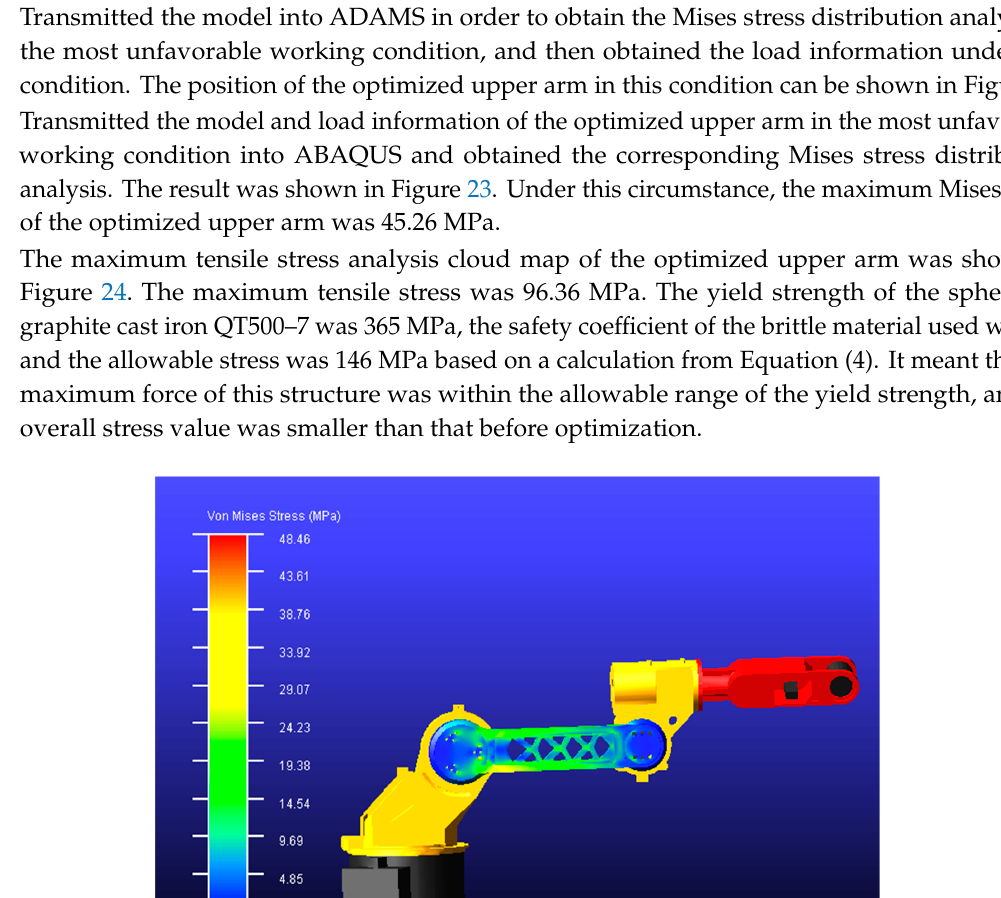
Figure 22. The position of the optimized upper arm in the most unfavorable working condition.